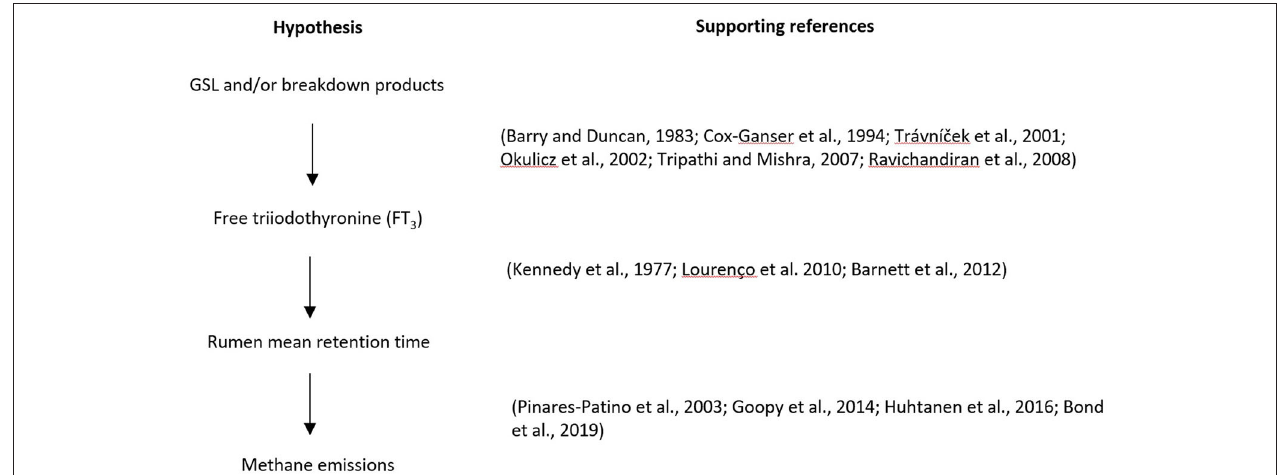
FIGURE 4 | Diagram of the proposed hypothesis and supporting